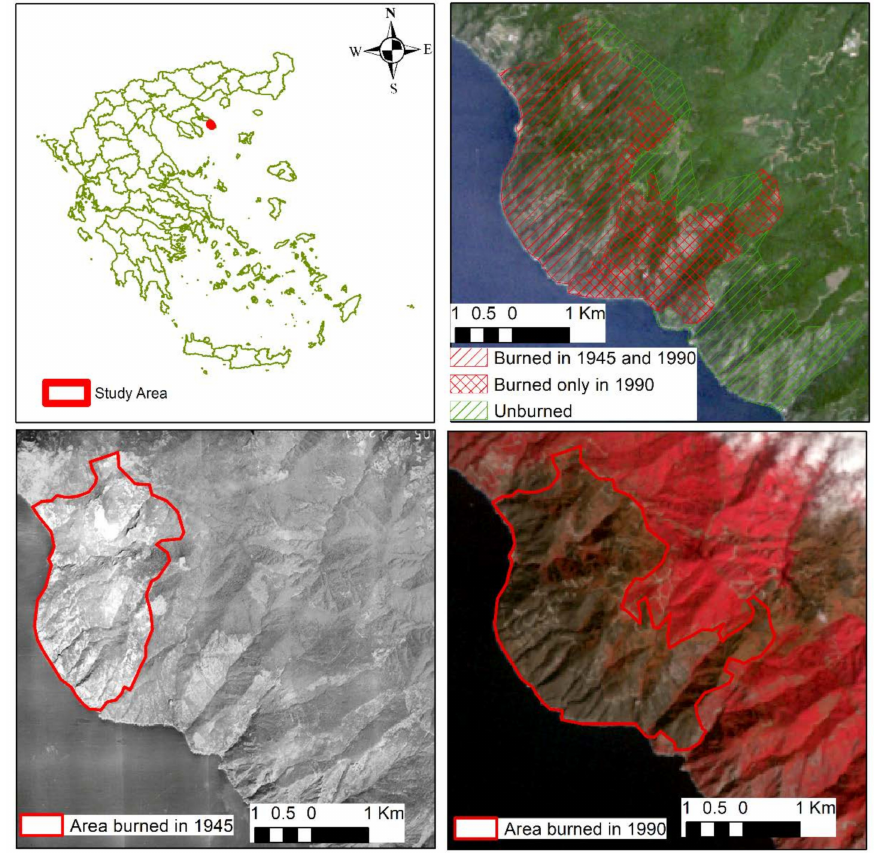
Figure 1. Location of the study area and burned area